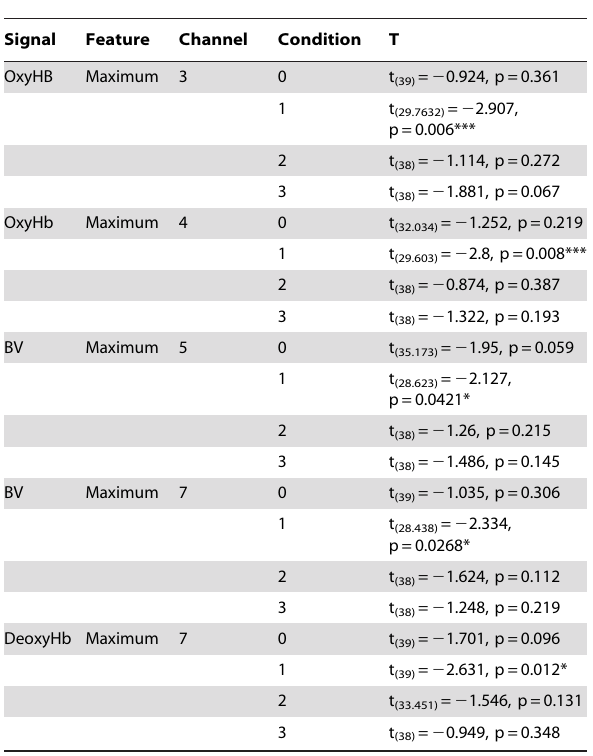
Table 3. Between-groups t-test comparison results in the four conditions in the fNIR-features that showed a significant group effect (Table 2a and